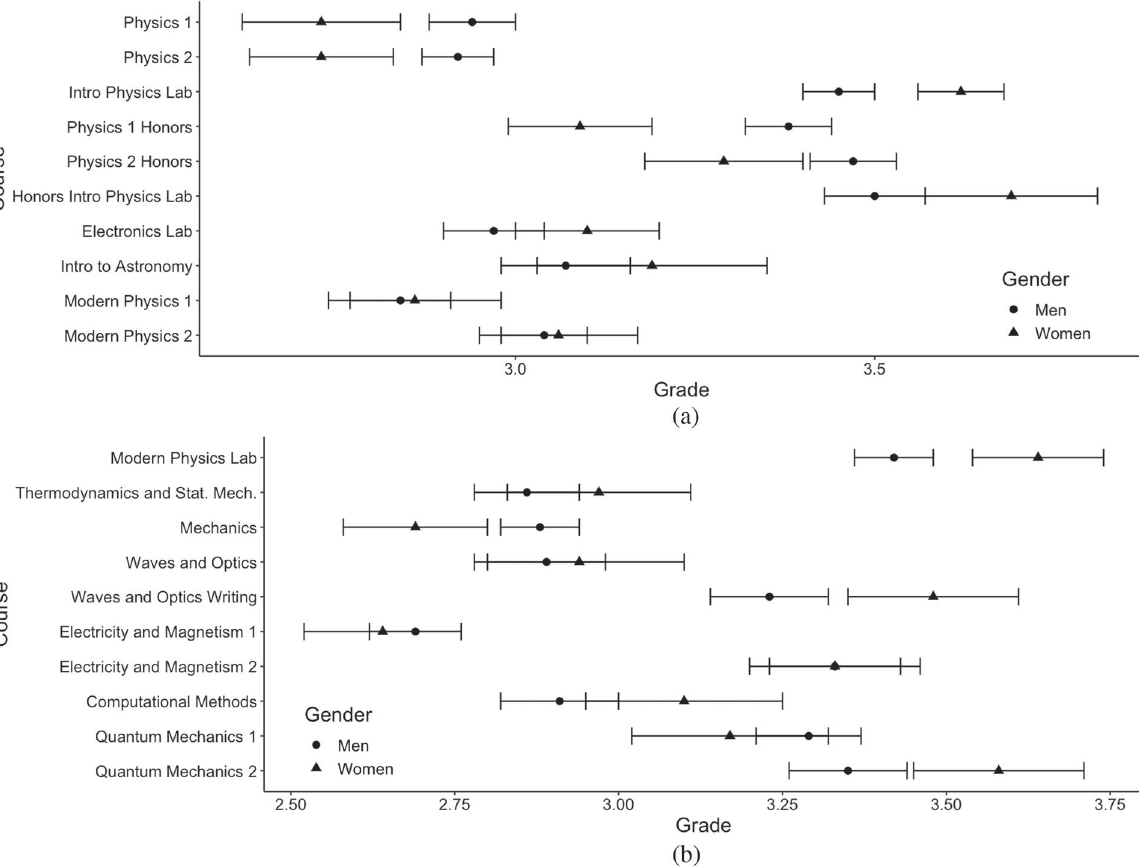
FIG. 2. Average grades of all students who declared a physics major by course, separated by gender. Ranges represent standard error of the mean. All courses are required except for Intro to Astronomy, Modern Physics 2, Electronics Lab, Modern Physics Lab, Electricity and Magnetism 2, Waves and Optics, Waves and Optics Writing, and Quantum Mechanics 2. (a) Grades by course for students in their first and second year of university, separated by gender and (b) Grades by course for students in their third year of university and beyond, separated by